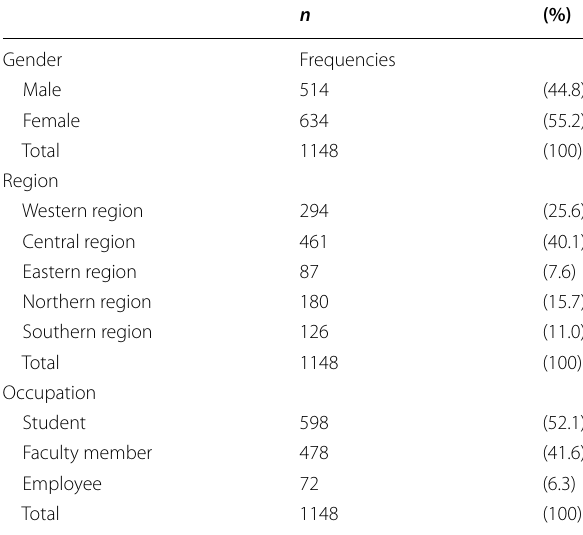
Table 1 Sample characteristics (full sample, n